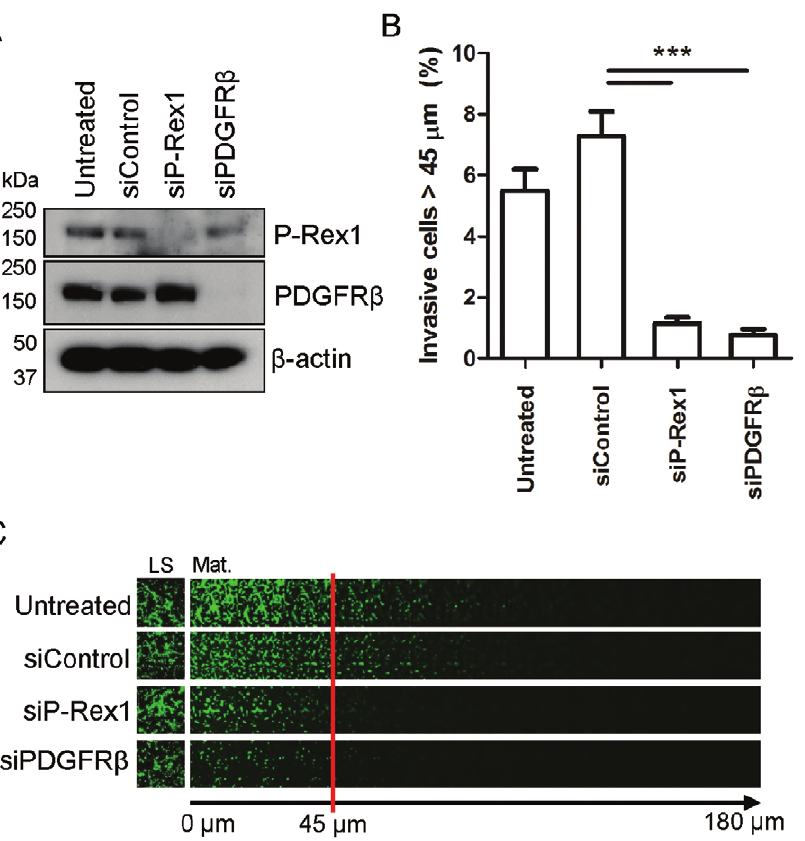
Figure 7. Expression of P-Rex1 and PDGFR b are required for invasive migration of WM852 melanoma cells. (A) Immunoblot showing depletion of P-Rex1 or PDGFR b following transfection of cells with non-targeting control or siRNA oligonucleotides directed against P-Rex1 or PDGFR b . (B,C) Invasive migration of WM852 cells into Matrigel following transfection with siRNA oligonucleotides targeting P-Rex1 or PDGF b was determined as for Fig. 3A. In (C), panels have been appended to demonstrate the adherence of the WM852 cells to the lower surface (LS) of the transwell.( 6 SEM, *** P , 0.0005 Mann-Whitney rank sum test, 3 independent experiments).